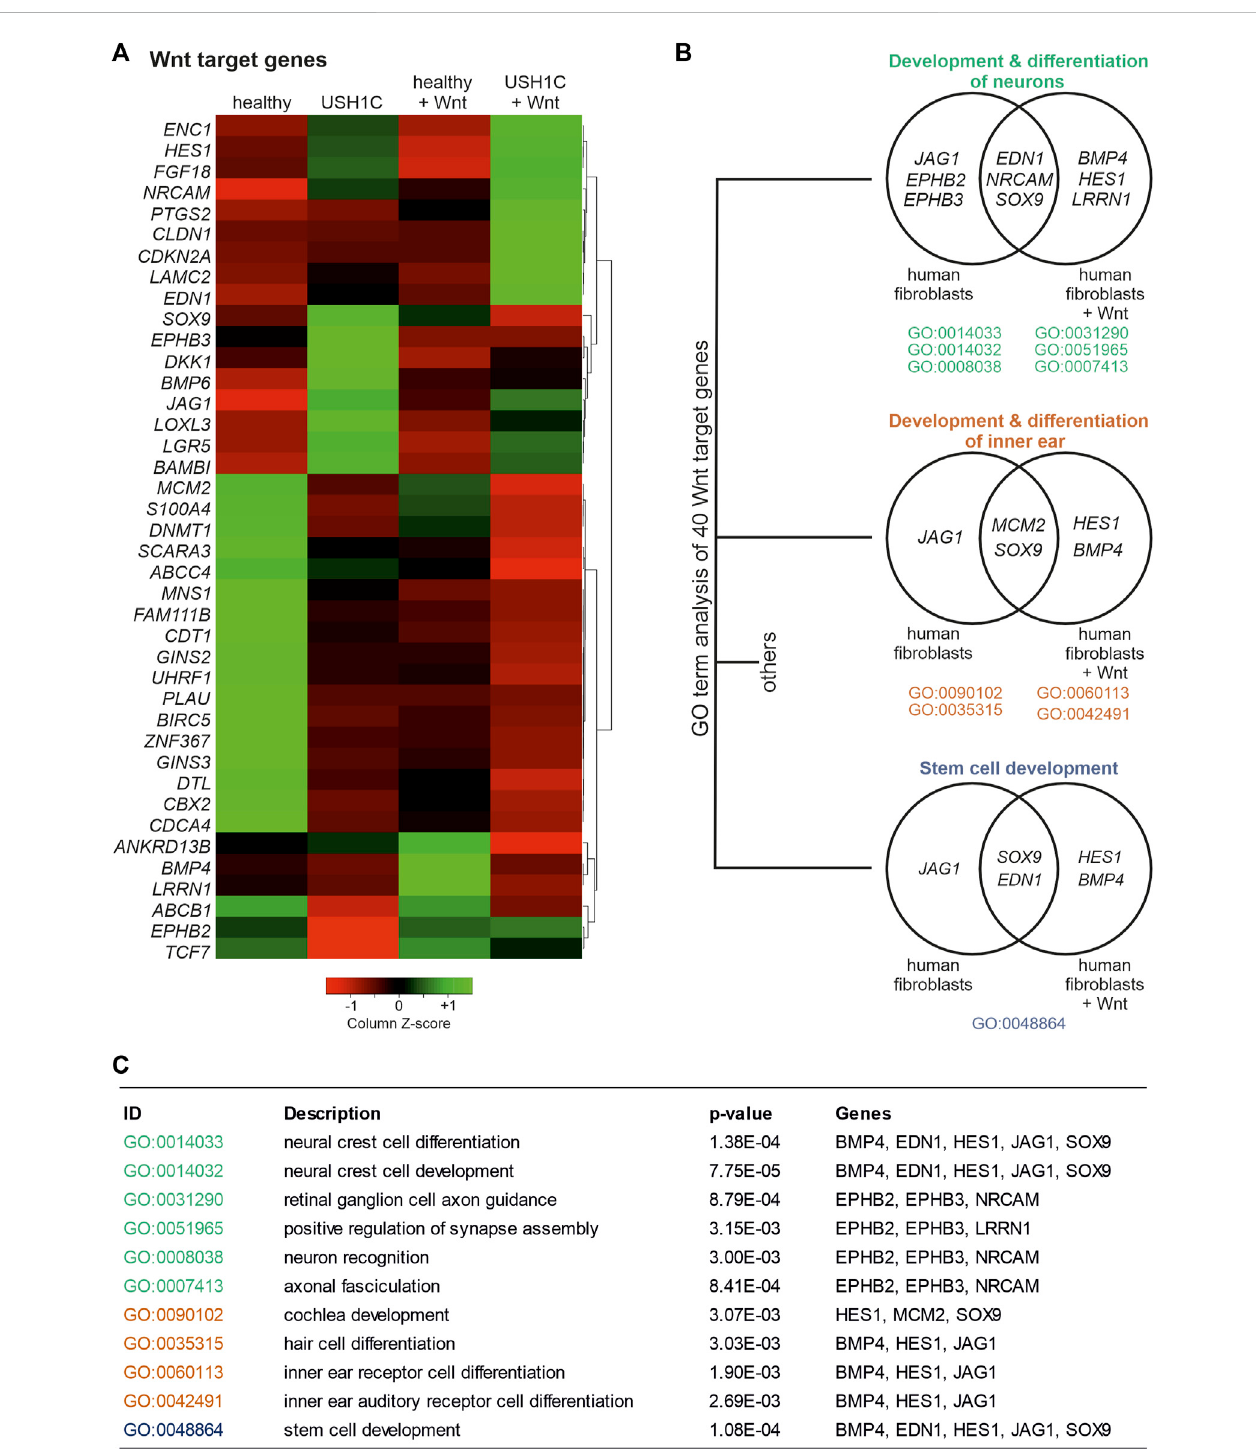
FIGURE 4 RNAseq analysis uncovers differential expression of Wnt target genes in USH1C R31*/R80Pfs*69 patient-derived fi broblasts. (A) Heatmap shows transformed FPKM-values scaled by z-score identifying 40 differentially regulated Wnt target genes in unstimulated and Wnt stimulated healthy (column 1 and 3) and USH1C R31*/R80Pfs*69 patient-derived ( USH1C ) fi broblasts (column 2 and 4). Red areas correspond to a relative downregulation in gene expression, whereas green areas represent a relative upregulation. (B) GO enrichment analysis showing dysregulated Wnt target genes to be critical for distinct biological processes, such as “ development and differentiation of neurons, ” “ development and differentiation of the inner ear, ” as well as “ stem cell development. ” (C) Detailed description of GO terms summarized in (B)